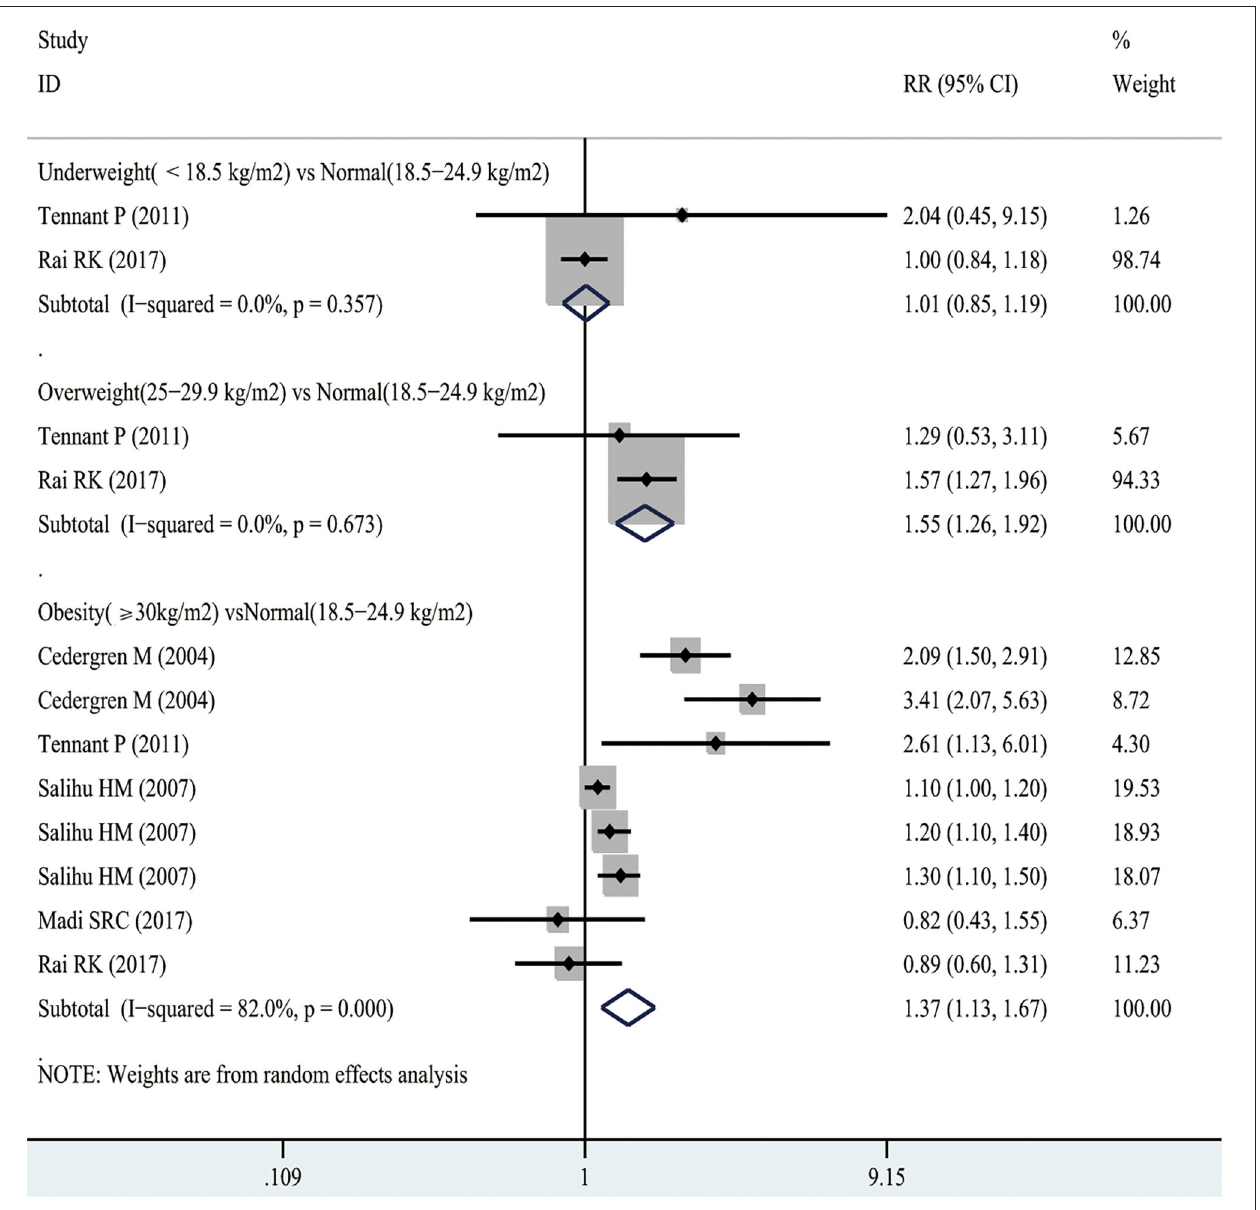
FIGURE 6 | Forest plots of maternal BMI and the risk of early neonatal